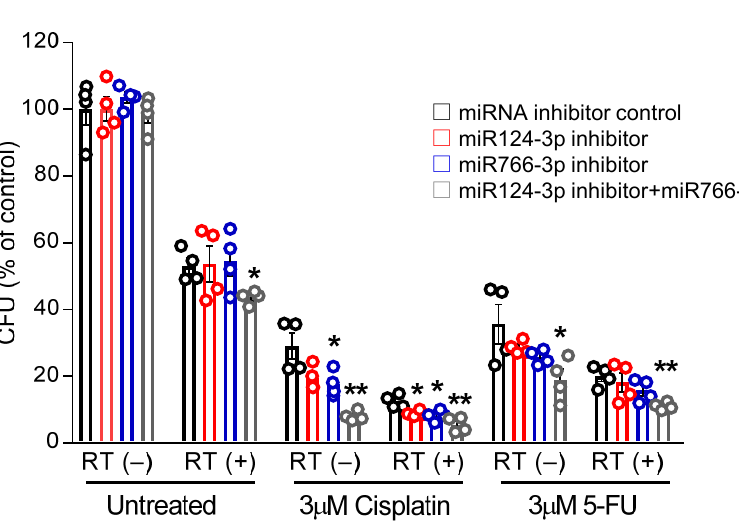
Figure 6. The effect of miR124-3p and miR766-3p inhibition on sensitizing resistant HNSCC cells to chemo-radiation therapy. ( A ) Measurement of apoptosis. Following transfection with miRNA inhibitors (10 nM each) for 24 h, CAL27/FP-R cells were treated with radiotherapy (8 Gy) alone or in combination with chemotherapeutic drug (cisplatin or 5-FU). After 24 h, cells were labeled with anti-annexin V-FITC antibody and PI and analyzed by flow cytometry. Dot plot data are shown in Figure S3C. ( B ) Measurement of drug-induced cytotoxicity. 24 h after transfection with miRNA inhibitors (10 nM each), CAL27/FP-R cells were exposed to 8 Gy radiation, and then with or without chemotherapy treatment (cisplatin or 5-FU) for 72 h, cytotoxicity was assessed by MTT assay. ( C ) Determination of clonogenic potential. CAL27/FP-R cells were transfected for 24 h and then exposed to 8 Gy radiation. With or without chemotherapeutic drug treatments as indicated, cells were stained with crystal violet, and CFUs were counted. A two-way ANOVA with Bonferroni’s correction for multiple comparisons was used to analyze group comparisons, and data are presented as means ± SD (n = 3). * p < 0.05, ** p < 0.01 (vs. miRNA inhibitor control). [# p < 0.05, ## p <